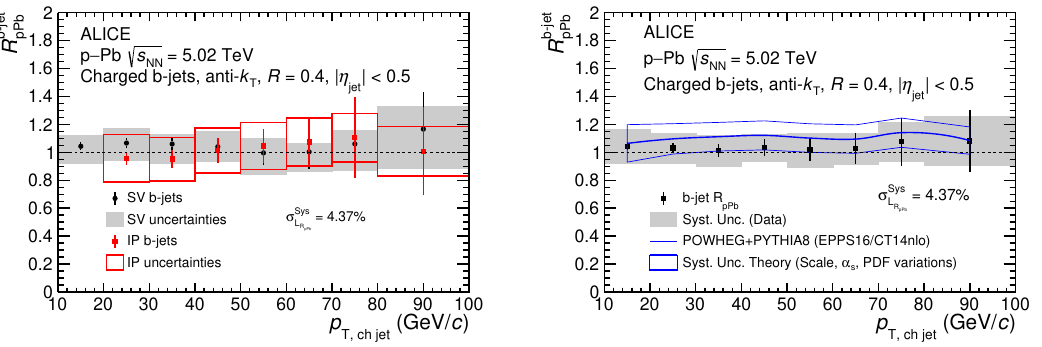
Figure 13. The b-jet fraction in pp collisions at √ s NN = 5 . 02 TeV (right), compared with POWHEG NLO pQCD calculations with PYTHIA 8 fragmentation.